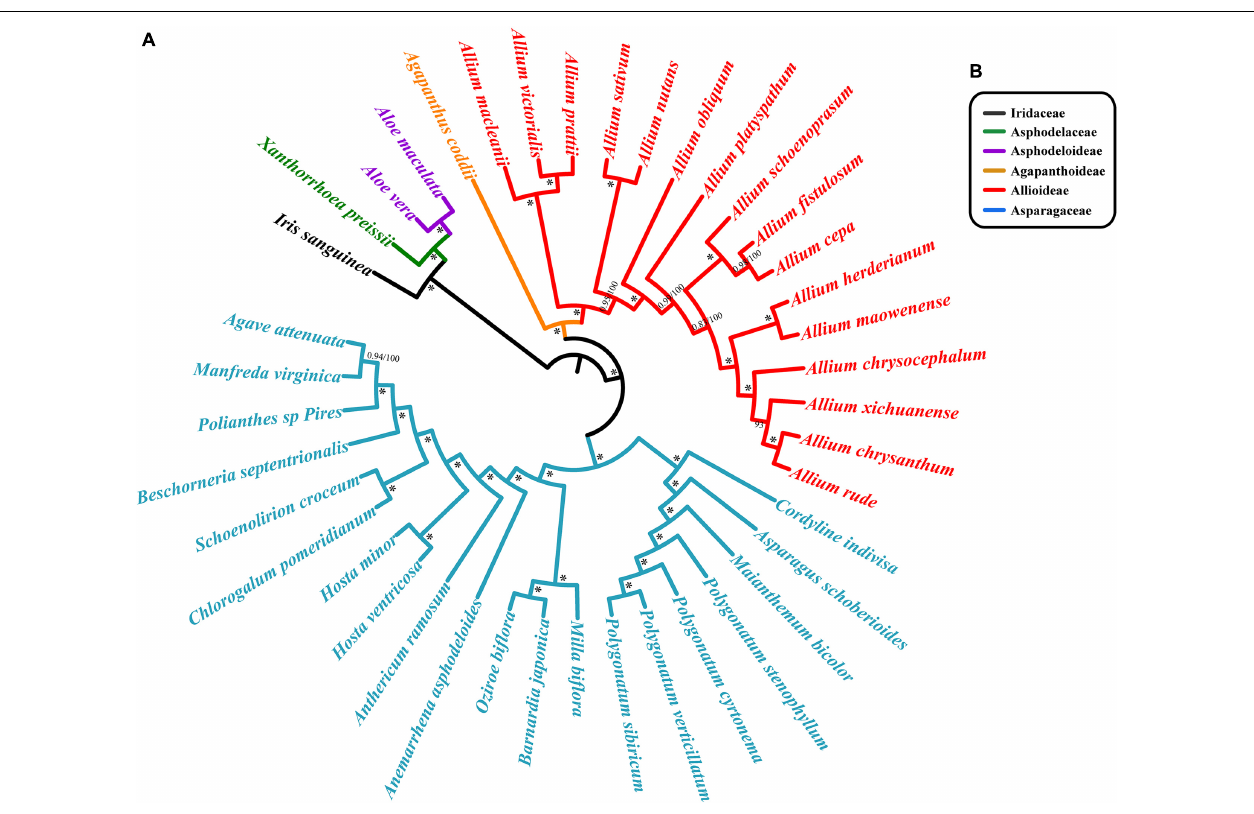
FIGURE 7 | Phylogenetic relationships of section Daghestanica species with related 35 species based on the whole cp genomes. (A) Tree constructed by Bayesian inference (BI) and maximum likelihood (ML) with the posterior probabilities of BI and the bootstrap values of ML above the branches, respectively. ∗ Represent maximum support in all two analyses. (B) Families of each species belong to, color of bar is consistent with the species’ color.